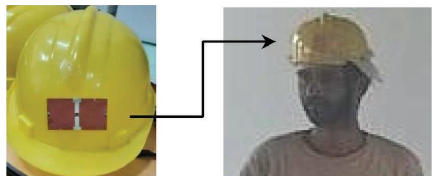
Figure 23: Tagged safety helmet mounted on construction